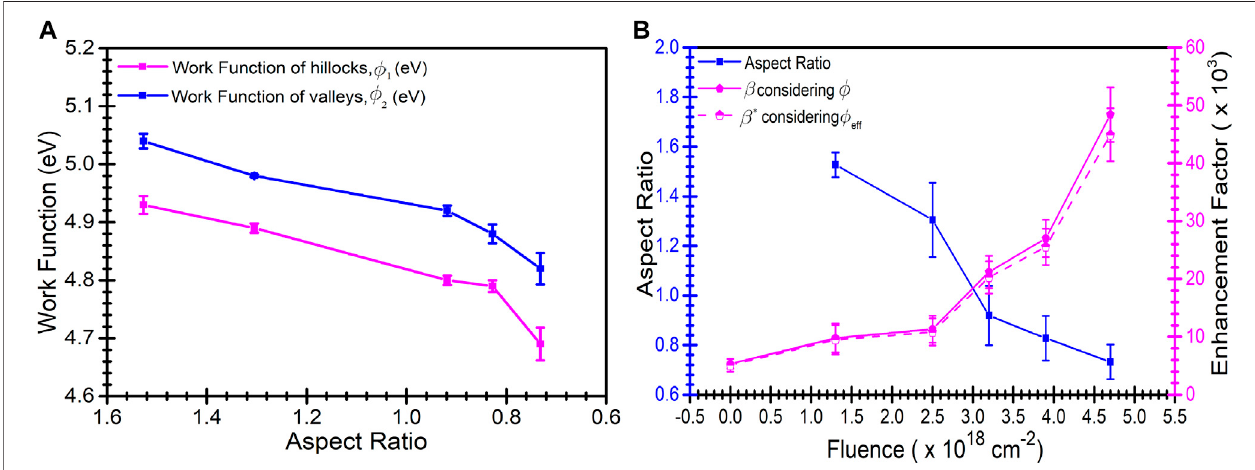
FIGURE8 |(A) Work functionof both hillocksand valleysvariationwithaspect ratio. (B) Variation ofaspect ratioand fi eldenhancementfactor ( β and β * ) calculated from both bulk ( ϕ ) and modi fi ed work function ( ϕ eff ) with beam fl uence.